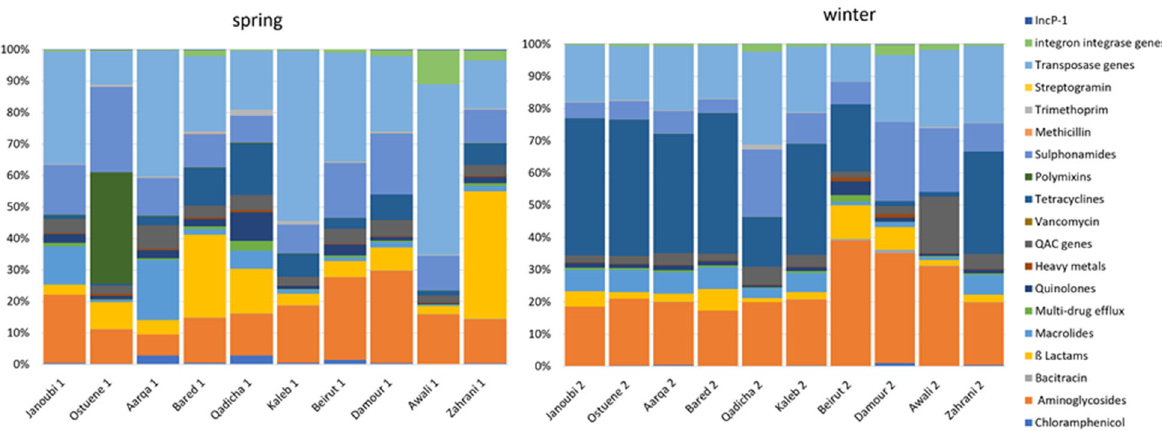
Figure 2. Proportional abundances of targeted genes grouped into gene families according to their function per river in spring and in winter in 10 estuarine Lebanese rivers samples. qac genes: genes conferring resistance to quaternary ammonium compounds.